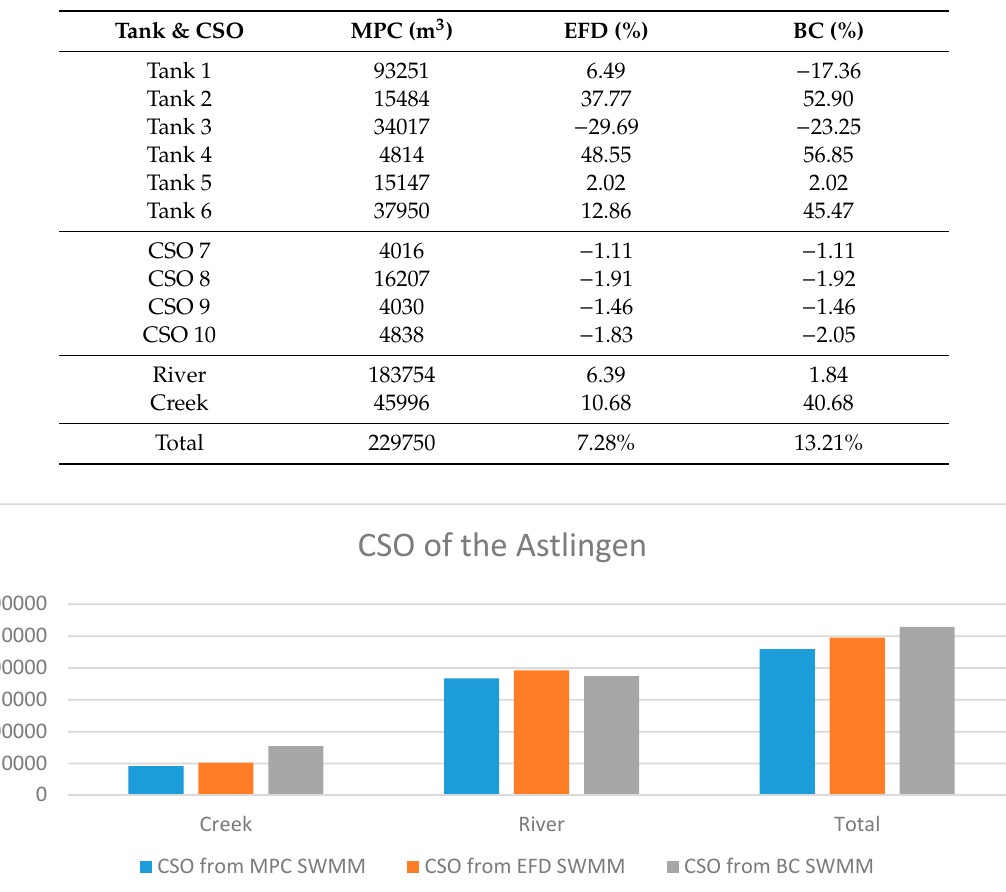
Table 6. Simulated CSO volumes (m 3 ) for the Model Predictive Control (MPC) scenario, and percentage difference from the BC and Equal-Filling Degree Verification (EFD) scenarios. Positive variations denote reductions in CSO volume, while negative values denote increases in discharges.